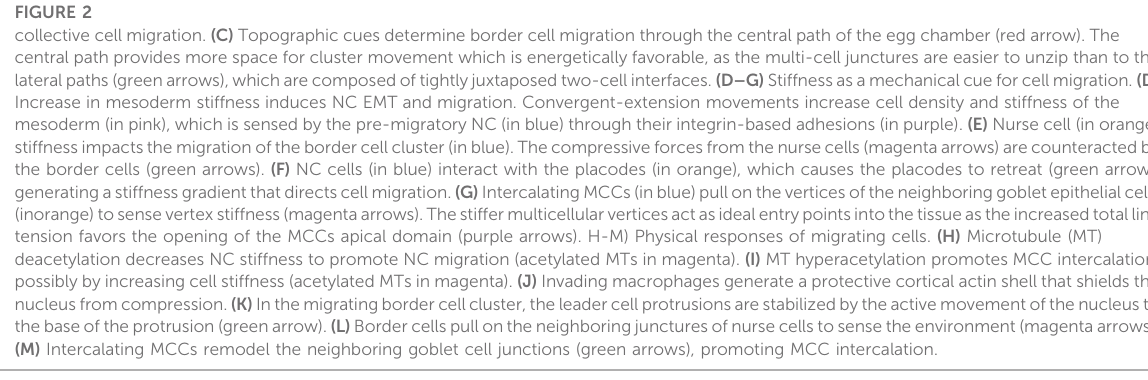
FIGURE 2 collective cell migration. (C) Topographic cues determine border cell migration through the central path of the egg chamber (red arrow). The central path provides more space for cluster movement which is energetically favorable, as the multi-cell junctures are easier to unzip than to the lateralpaths(greenarrows),whicharecomposedoftightlyjuxtaposed two-cellinterfaces. (D – G) Stiffnessasamechanicalcueforcellmigration. (D) Increase in mesoderm stiffness induces NC EMT and migration. Convergent-extension movements increase cell density and stiffness of the mesoderm (in pink), which is sensed by the pre-migratory NC (in blue) through their integrin-based adhesions (in purple). (E) Nurse cell (in orange) stiffnessimpactsthemigrationofthebordercellcluster(inblue).Thecompressiveforcesfromthenursecells(magentaarrows)arecounteractedby the border cells (green arrows). (F) NC cells (in blue) interact with the placodes (in orange), which causes the placodes to retreat (green arrow), generatingastiffnessgradientthatdirectscellmigration. (G) IntercalatingMCCs(inblue)pullontheverticesoftheneighboringgobletepithelialcells (inorange)tosensevertexstiffness(magentaarrows).Thestiffermulticellularverticesactasidealentrypointsintothetissueastheincreasedtotalline tension favors the opening of the MCCs apical domain (purple arrows). H-M) Physical responses of migrating cells. (H) Microtubule (MT) deacetylation decreases NC stiffness to promote NC migration (acetylated MTs in magenta). (I) MT hyperacetylation promotes MCC intercalation, possibly by increasing cell stiffness (acetylated MTs in magenta). (J) Invading macrophages generate a protective cortical actin shell that shields the nucleusfromcompression. (K)